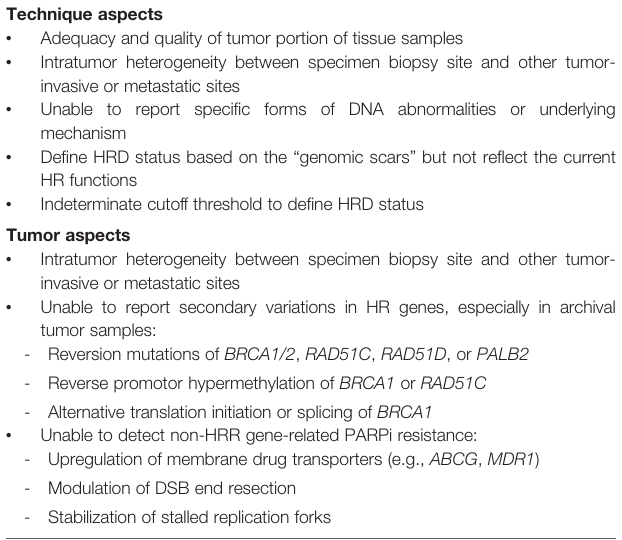
TABLE 4 | Limitations of the current HRD